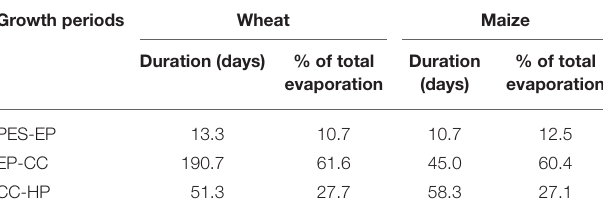
TABLE 9 | Evaporation losses with respect to growth stages. Growth periods Wheat